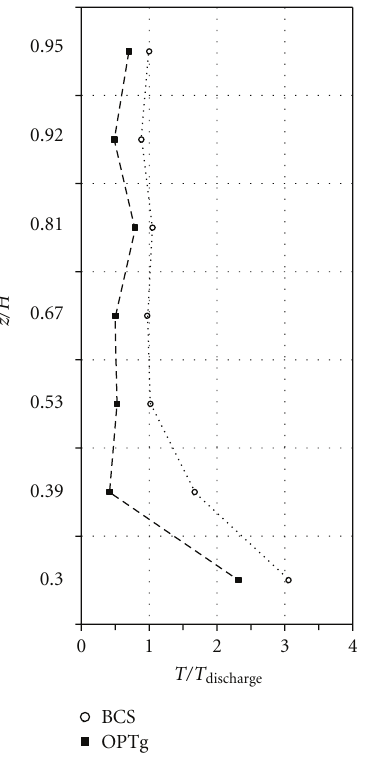
Figure 15: Comparative profiles of nondimensional air tem- perature, T/T discharge ( y/W = 0 . 44, z/H ), in the food products conservation area—OPTg case study.